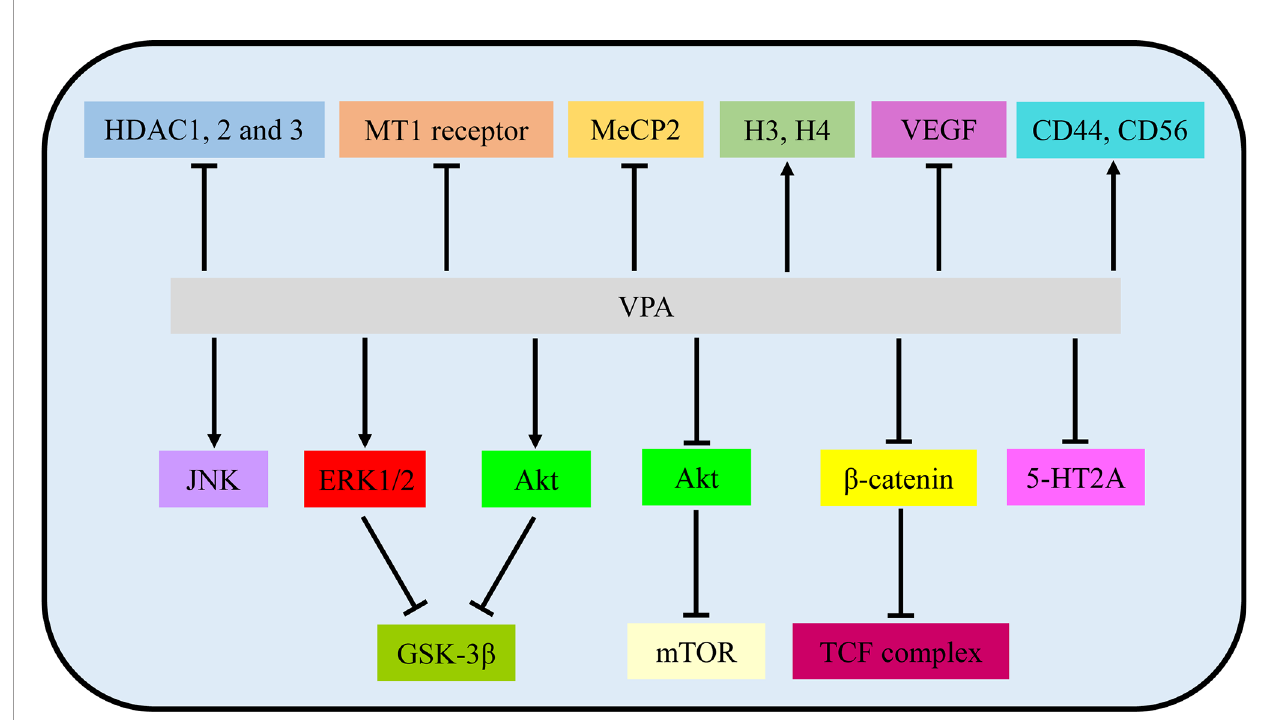
FIGURE 2 | VPA exerted therapeutic effects via involvement with signaling pathways and molecular targets. VPA, valproic acid; HDAC, histone deacetylase; MT1, MT1: melatonin 1; MeCP2, methyl CpG binding protein 2; H3/4, histone 4; VEGF, vascular endothelial growth